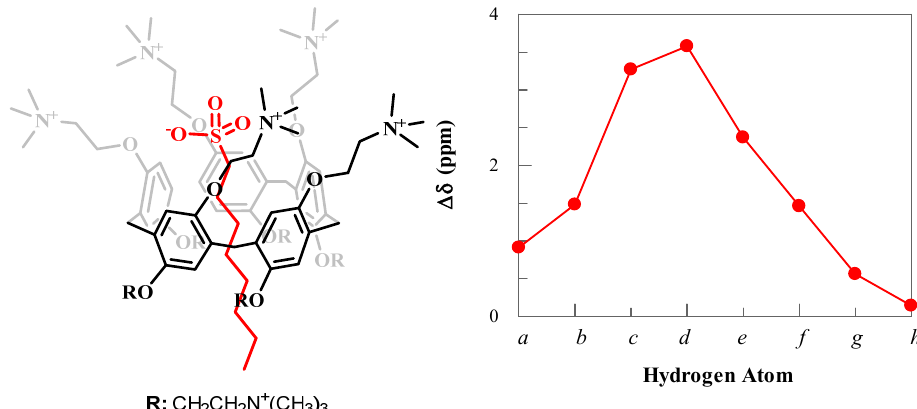
Figure 5. ( Left ) Plot of the magnitude of complexation induced chemical shift, Δ δ , as a function of the hydrogen atom position (starting at the sulfonate group). ( Right ) Schematic picture of the host:guest complex showing hydrogens Hc and Hd fully incorporated into the aromatic region of the host. For simplicity only two trimethylammonium groups of pillararene are shown.